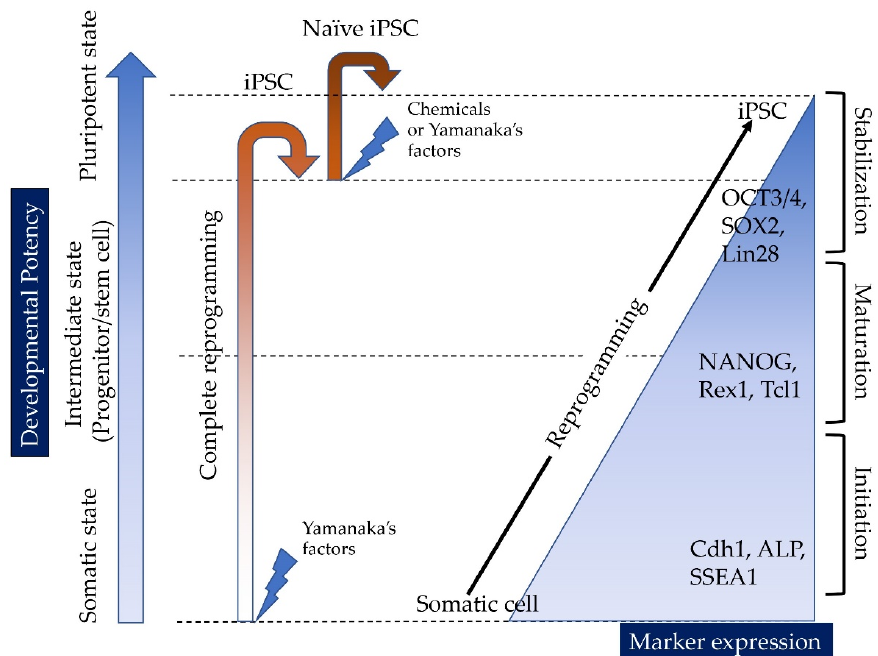
Figure 1. Cell state and molecular events during the reprogramming of somatic cells into iPSCs. When complete repro- gramming occurs, somatic cells are successfully converted into iPSCs. The resulting iPSCs can be further reprogrammed into naïve iPSCs through transfection with vectors carrying Yamanaka’s factors or via treatment with chemicals. There are at least three phases with respect to (de-)differentiation (“somatic state”, which may correspond to the initiation stage, “intermediate state”, which may correspond to the maturation stage, and “pluripotent state”, which may correspond to the stabilization stage), according to Samavarchi-Tehrani et al. [12]. Importantly, several molecular markers define each of the above phases, according to Samavarchi-Tehrani et al. [12] and Polo et al. [13]. CDH1, E-cadherin; ALP, alkaline phosphatase; SSEA-1, stage-specific embryonic antigen 1; NANOG, nanog homeobox; REX1, reduced expression protein-1; TCL1, T cell lymphoma breakpoint 1; OCT3/4, octamer-binding transcription factor-3/4; SOX2, sex-determining region Y-box 2; LIN28,